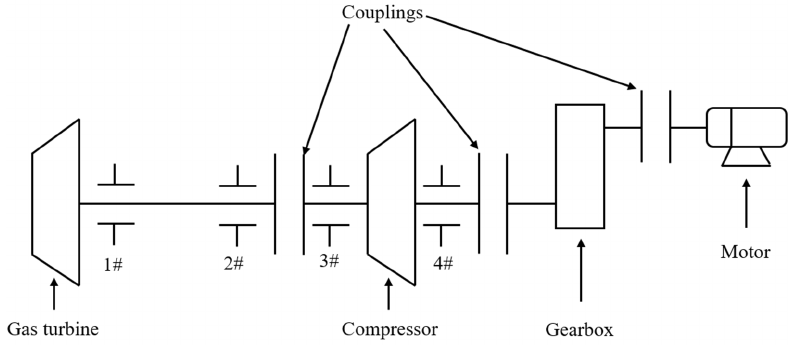
Figure 14. Device structure of collected mechanical fault.